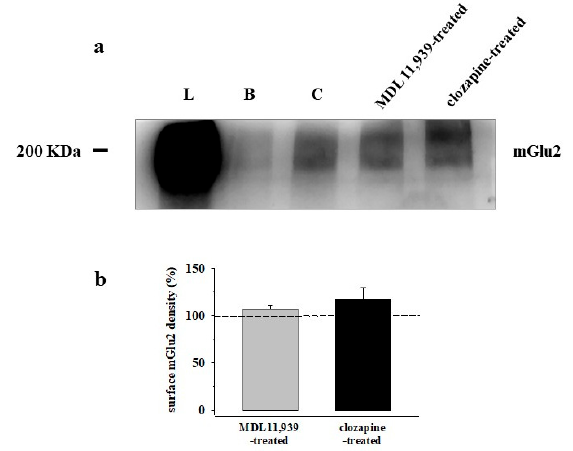
Figure 5. Preincubation of PFc synaptosomes with MDL11,939 or with clozapine does not modify the surface expression of the mGlu2 receptor subunits. ( a ) Representative Western blot analysis of the density of the mGlu2 receptor subunits in PFc synaptosomal plasma membranes following preincubation of synaptosomes with MDL11,939 (1 µ M) or with clozapine (10 µ M). The blot compares the total synaptosomal lysate (L) and the synaptosomal membranes of particles that were not exposed to biotin, but were subjected to streptavidin pulldown (B), the synaptosomal membranes of untreated particles that were incubated with biotin and then were subjected to streptavidin pulldown (C), the synaptosomal membranes from MDL11,939-treated particles that were incubated with biotin and then were subjected to streptavidin pulldown MDL11,939 (1 µ M), and the synaptosomal membranes of clozapine-treated particles that were incubated with biotin and then were subject to streptavidin pulldown (10 µ M). The figure in panel ( a ) is representative of five different experiments carried out on different days with samples from different animals. ( b ) Changes in the mGlu2 receptor protein surface density in MDL11,939 (grey bar) and in clozapine (black bar) treated synaptosomal plasma membranes when compared to untreated particles (here indicated as a dotted line). Data are expressed as percent changes versus respective